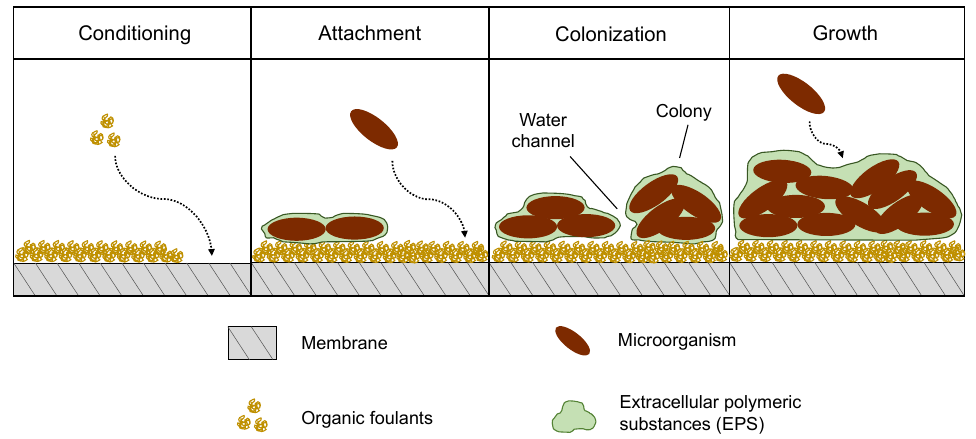
Figure 8. Schematic representation of biofouling evolution stages.